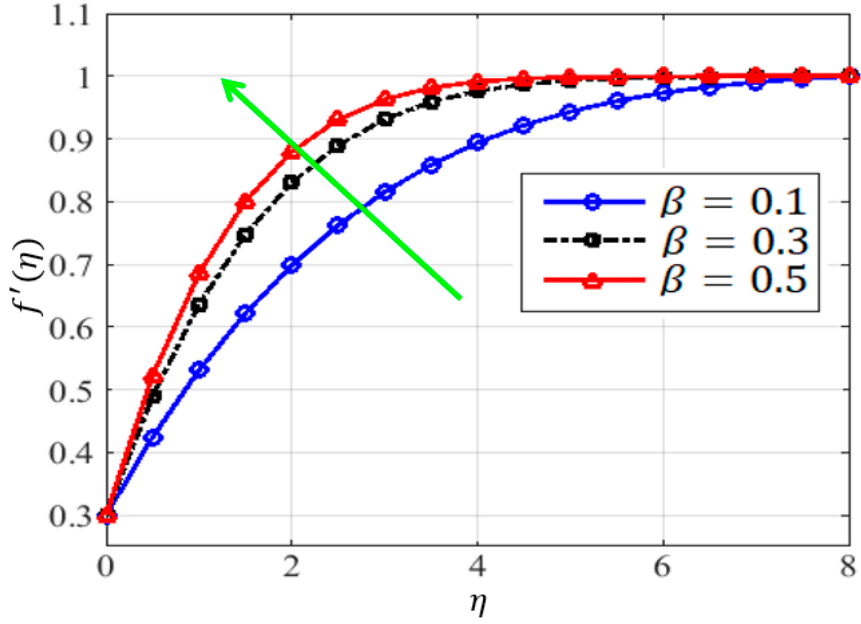
Figure 5. Impact of Casson fl uid viscosity force parameter on velocity pro fi le.